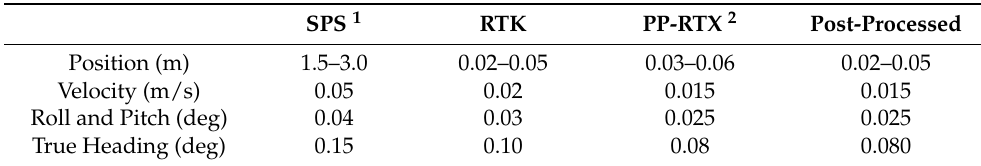
Table 2. Applanix APX-18 UAV performance specifications and root mean square error (Source: